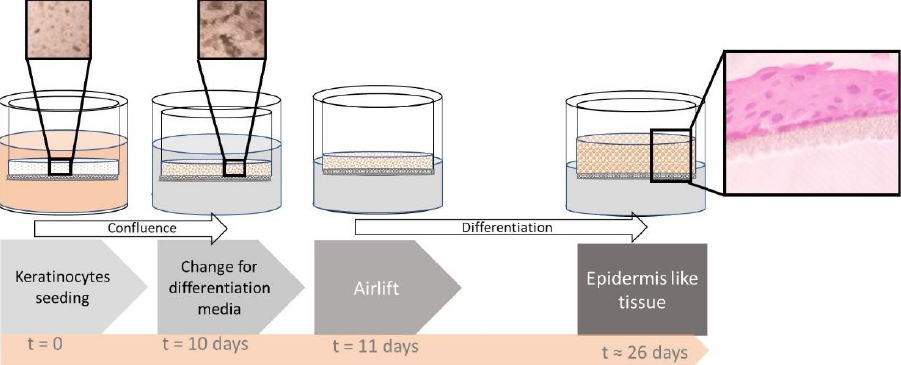
Figure 1. Schematic representation of the keratinocyte differentiation process. Microscopic photographs of the cell culture in the upper boxes showing the cell density (at seeding time and after 10-day culture) and a histological image of the differentiated tissue in the side box (stained with eosin-hematoxylin).